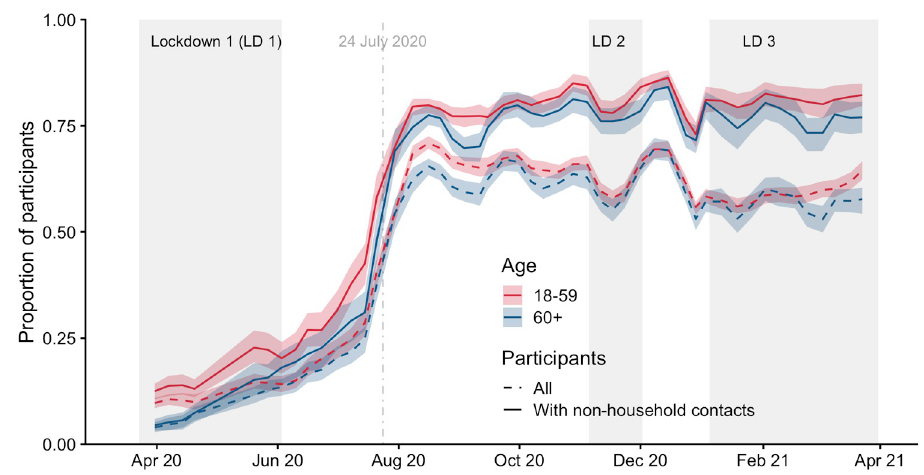
Fig 4. Proportion of adult participants who report wearing a mask by age category with 95% CI of bootstrapped proportion. Proportions plotted for all participants and for participants who reported any nonhousehold contacts, with the start date of face covering mandates in some settings indicated on July 24, 2020. CI, confidence interval; LD, lockdown. https://doi.org/10.1371/journal.pmed.1003907.g004 Mean contacts for adult participants over 18 years of age grouped by annual income levels (less than £20k, £20k to £44.9k, and over £45k), were similar and follow consistent patterns of decreasing during lockdowns and increasing slightly between the first and second lockdown (Fig 5B).